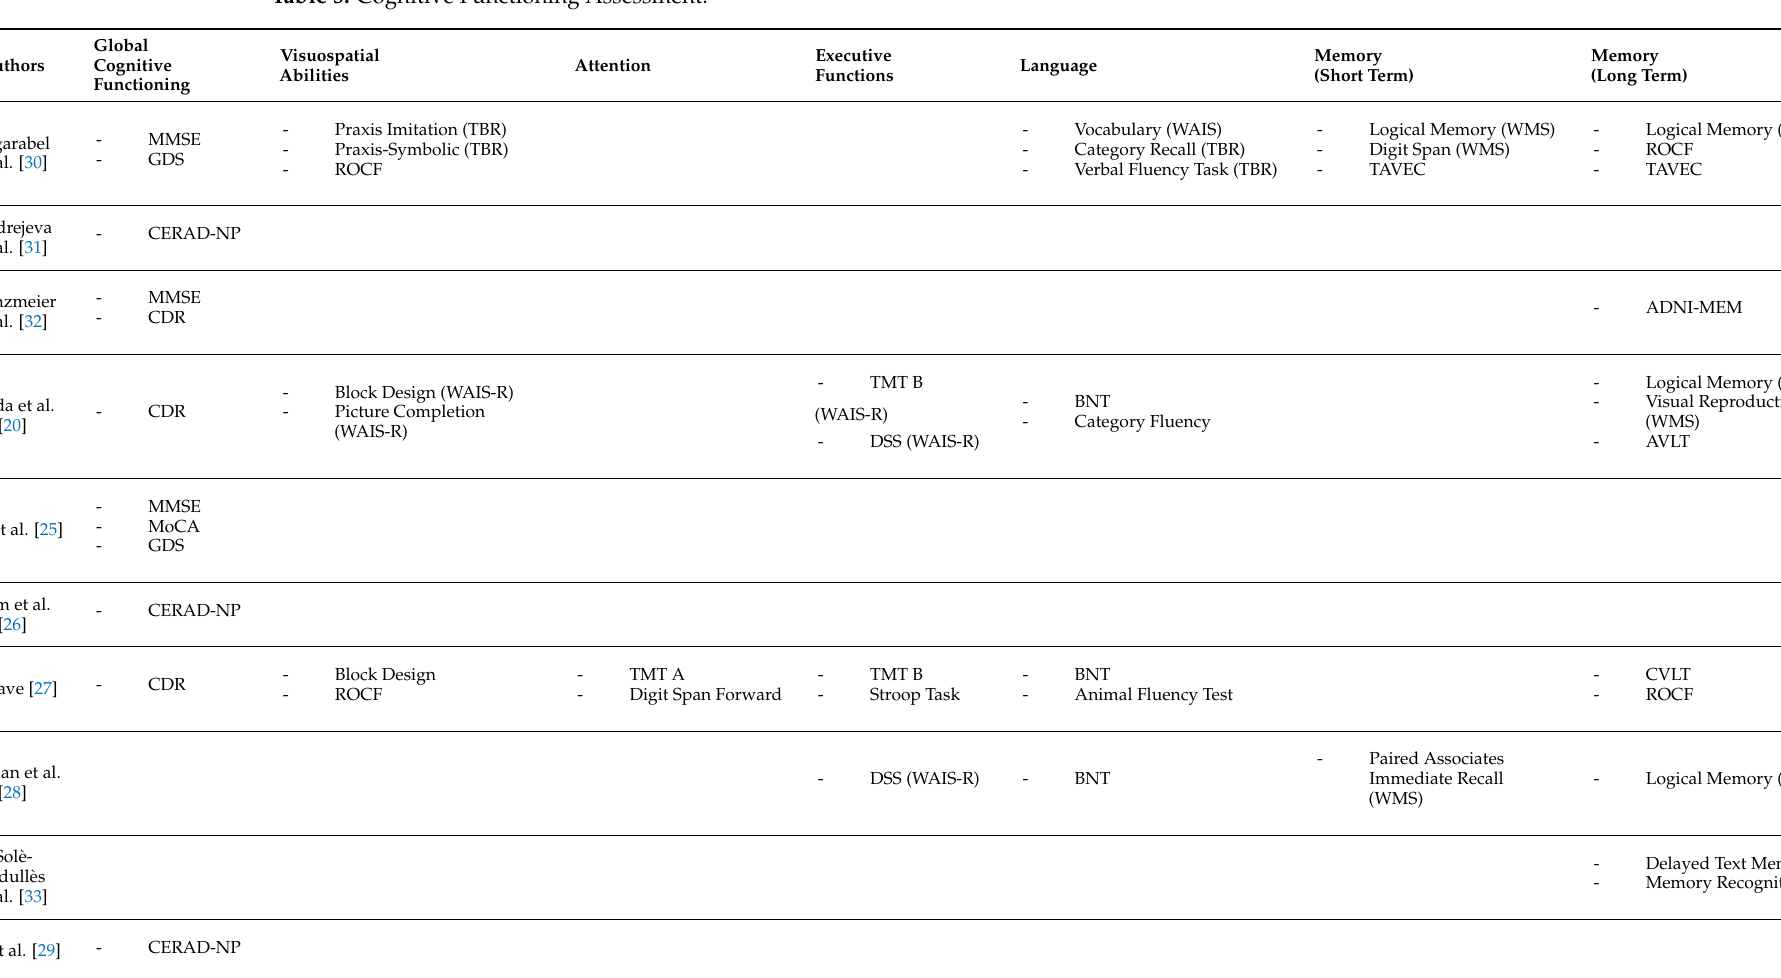
Table 5. Cognitive Functioning